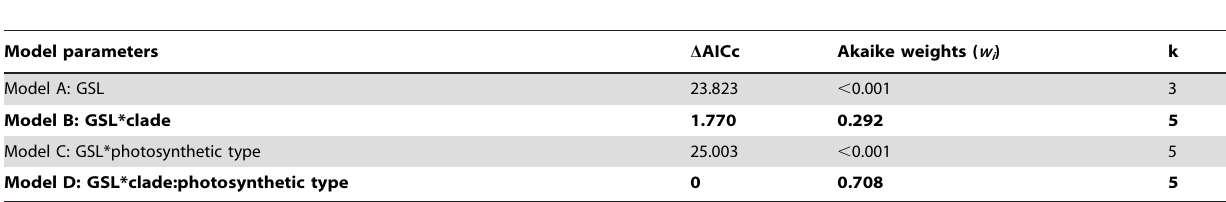
Table 1. Comparison of models predicting growing season productivity (GSP; estimated with integrated NDVI) using growing season length (GSL) and its interaction with clade and photosynthetic